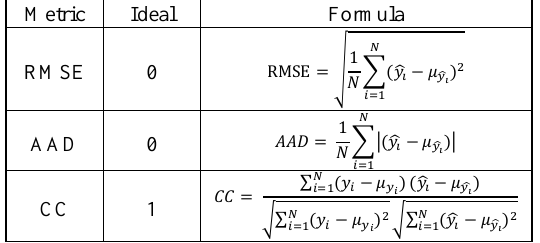
Table 2. Quality assessment results for each index